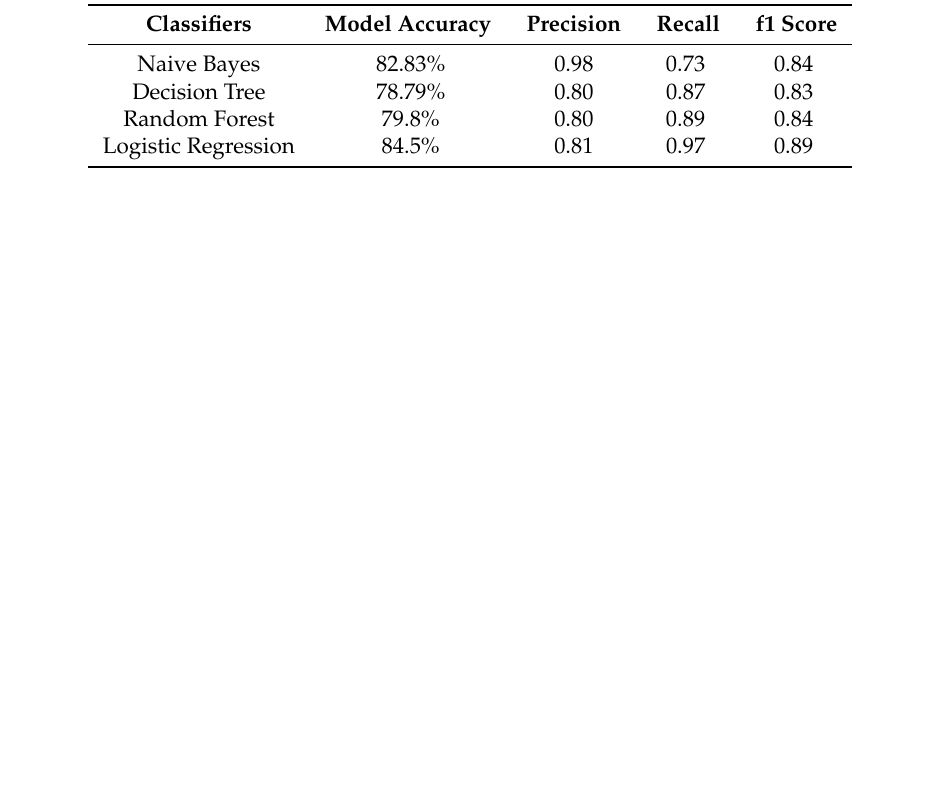
Table 4. Scenario 2 results of